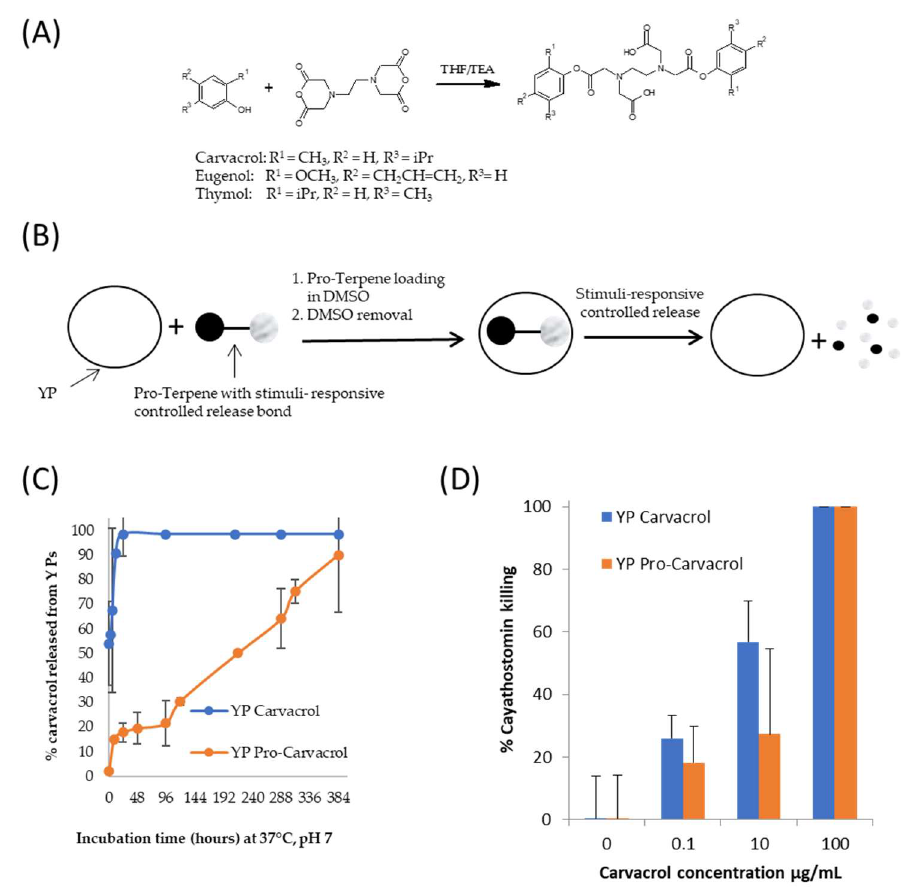
Figure 7. ( A ) Synthesis of pro-terpenes from parent terpene compounds (eugenol, carvacrol, thymol) and EDTA dianhydride, ( B ) schematics of pro-terpene loading in YPs and stimuli-controlled terpene release, ( C ) kinetics of carvacrol release from YP carvacrol and YP pro-carvacrol in 0.1 M phosphate buffer saline (PBS, pH 7) at 37 ◦ C at a concentration of 1 mg carvacrol/mL, and ( D ) in vitro activity of carvacrol samples in cyathostomin egg-to-larvae assay. Figures adapted from Reference [39] and reproduced with permission from